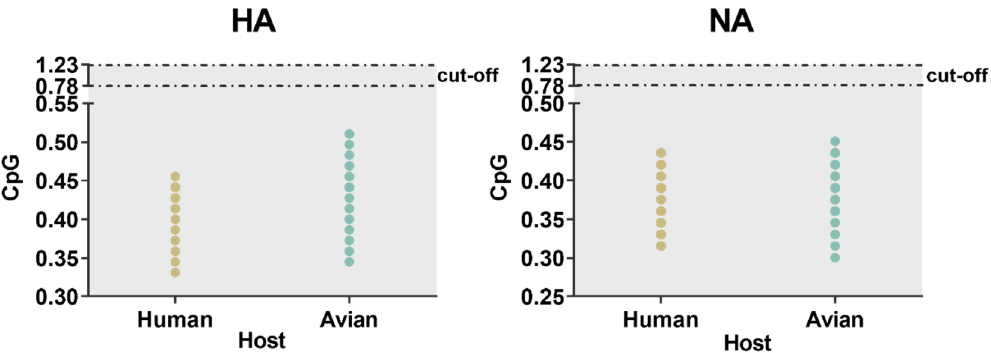
Figure 8. The ratio of CpG dinucleotide of strains of avian and human in HA and NA. When the relative dinucleotide abundances are < 0.78, it indicates that dinucleotides are underrepresented. The color distribution is consistent with the previous figure.